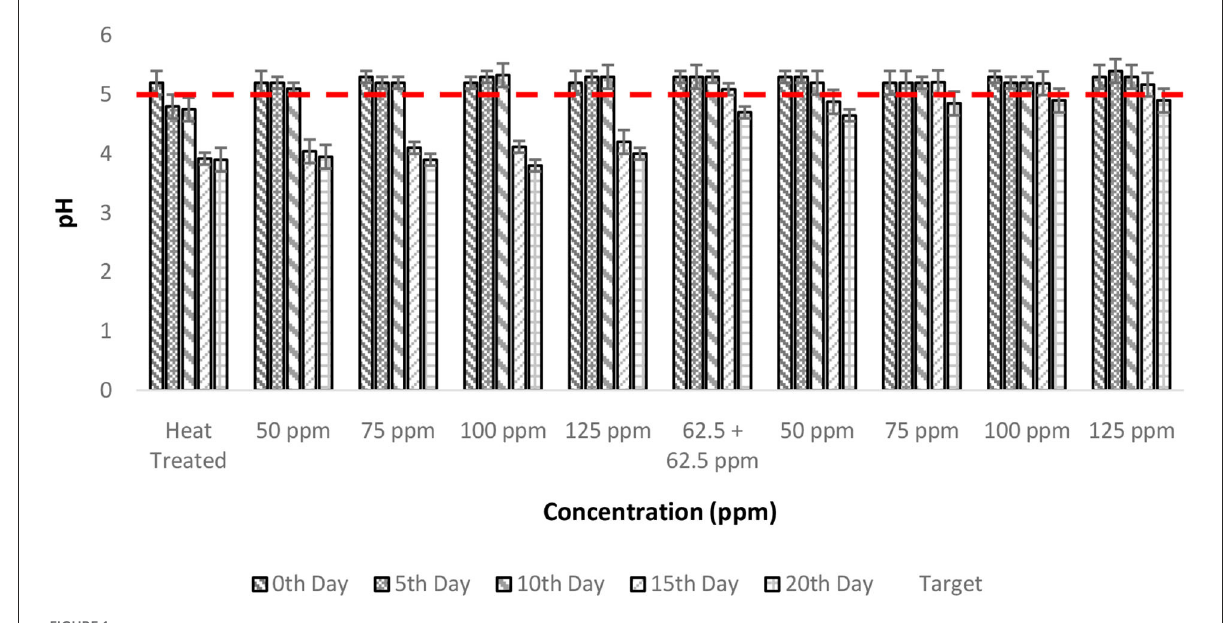
FIGURE1 pH vs. concentration plot of bio-preservatives during the storage period.